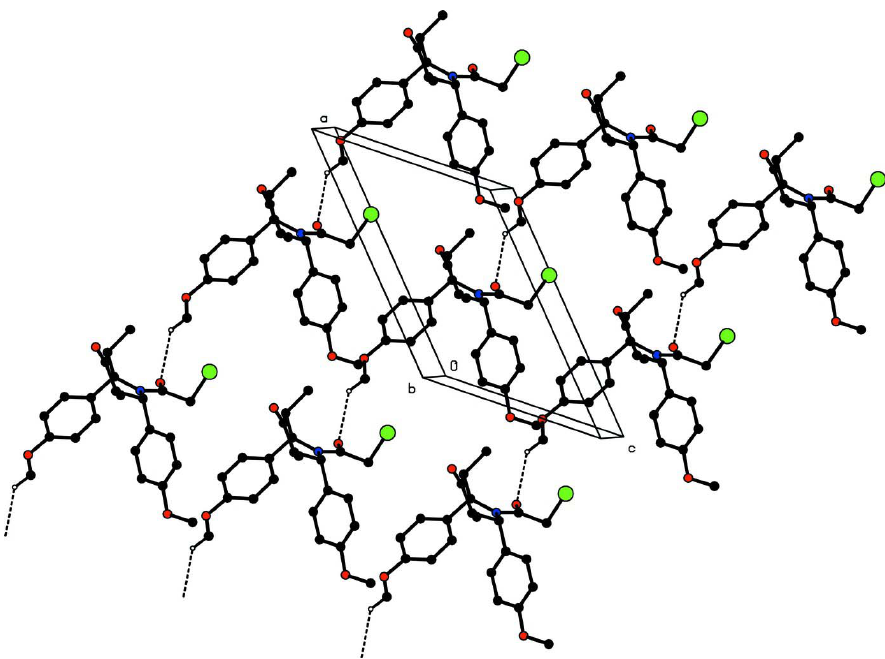
The crystal packing of the title compound. H atoms not involved in hydrogen bonding (dashed lines) have been omitted for